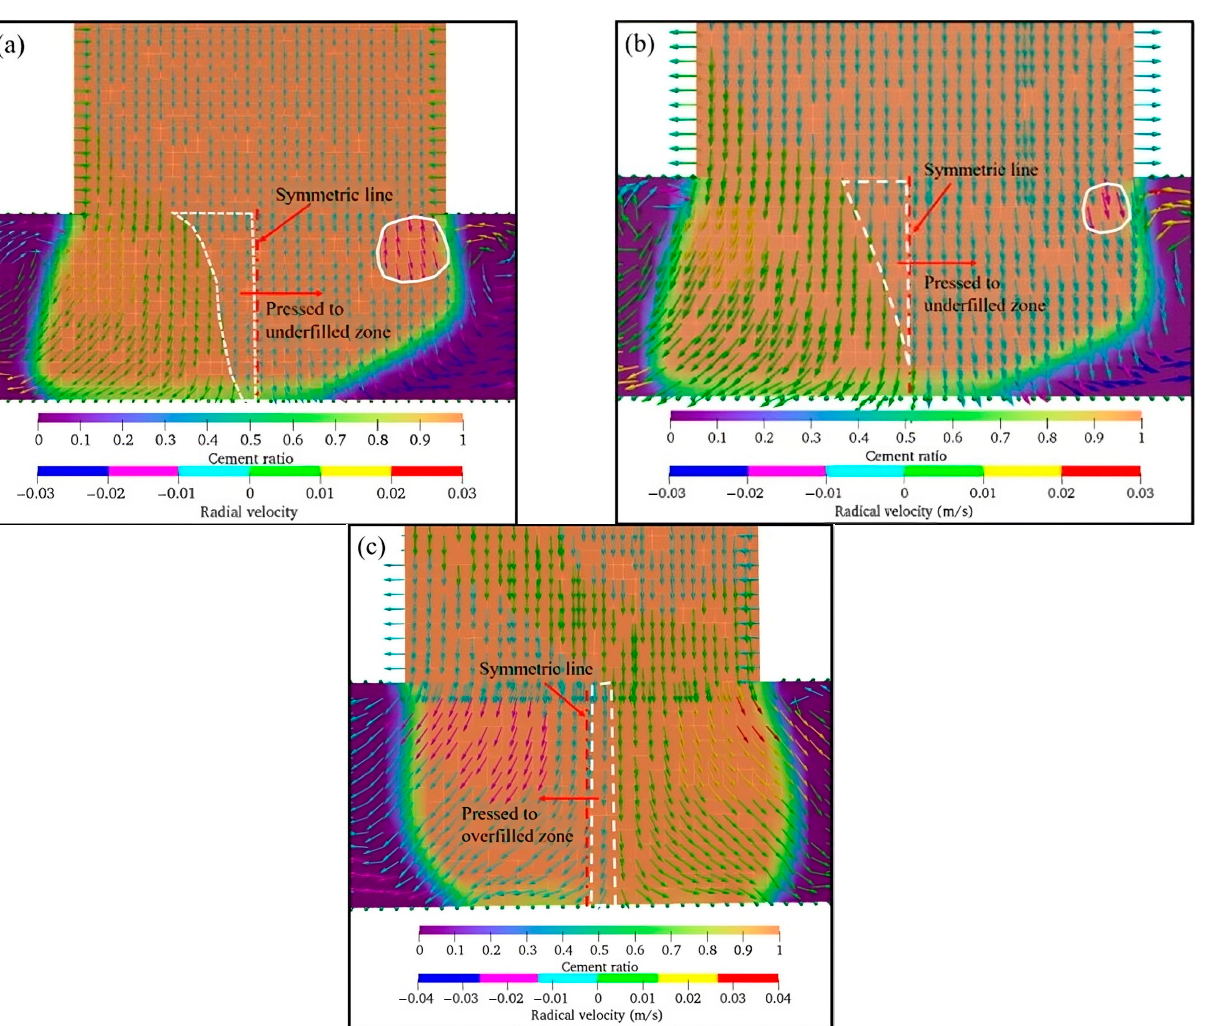
Figure 8. Cement ratio and velocity vector with R = 30 mm, ζ = 1.0, using ( a ) rectangular, ( b ) trapezoidal, and ( c ) Gaussian-shaped nozzles.